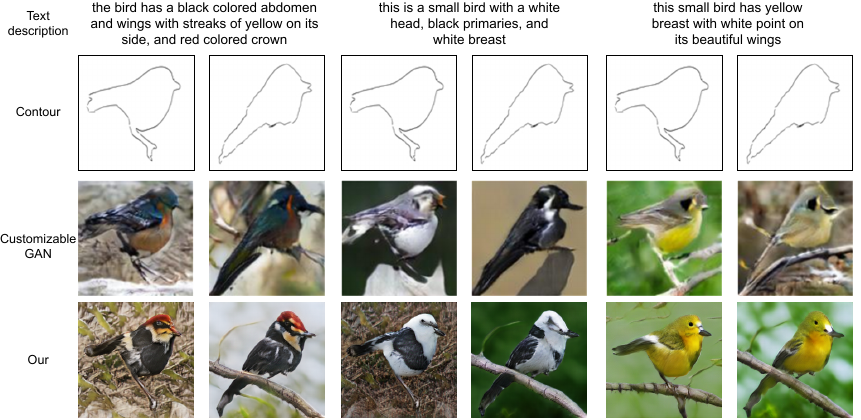
Figure 7. The qualitative comparison results between CustomizableGAN [16] and our customized method are shown above. Both the text and contour information in the figure were input manually.